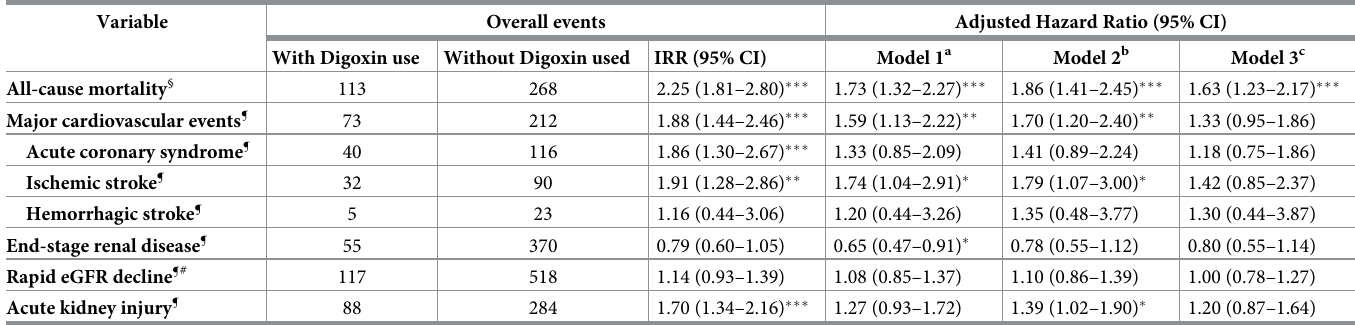
Table 2. Association between digoxin used or not and all-cause mortality, major cardiovascular events, and renal function decline in patients with chronic kidney disease using intention-to-treat